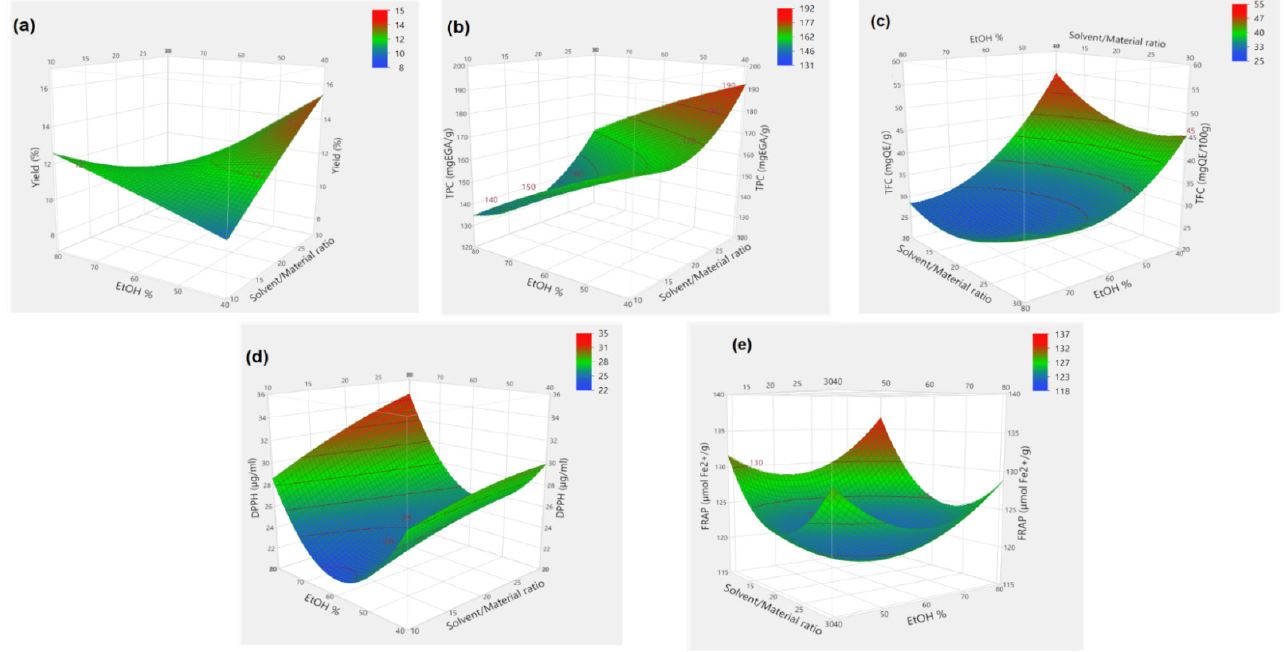
Figure 3. Three-dimensional plots for ultrasound-assisted extraction of Moroccan propolis, showing optimal compromise zone leading to the best value of ( a ) yield of extraction, ( b ) total polyphenol content, ( c ) total flavonoid content, ( d ) DPPH-IC 50 , and ( e ) FRAP-EC 50 as a function of solvent/propolis ratio and ethanol concentration and by fixing the sonication time in its optimal value .